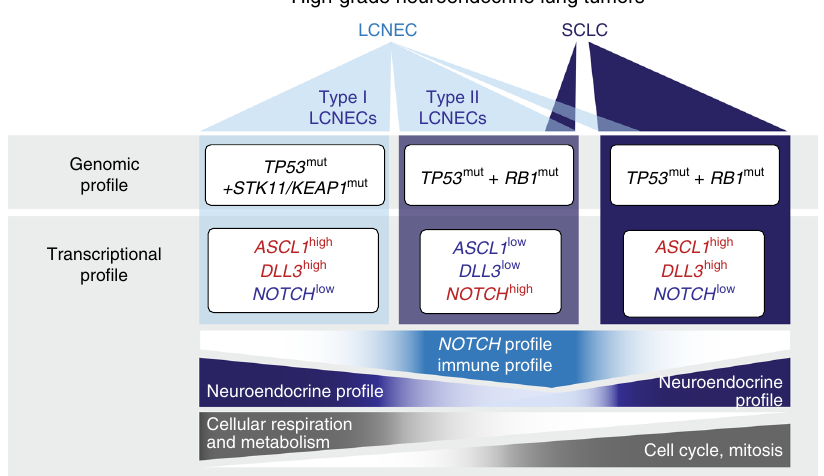
Fig. 4 Schematic overview of somatic alterations and expression pro fi les in high-grade neuroendocrine lung tumors. Signi fi cantly mutated genes are shown in black and differentially expressed genes are highlighted in red and blue, describing higher and lower expression, respectively. Upregulated expression pro fi les and signaling pathways are indicated by color